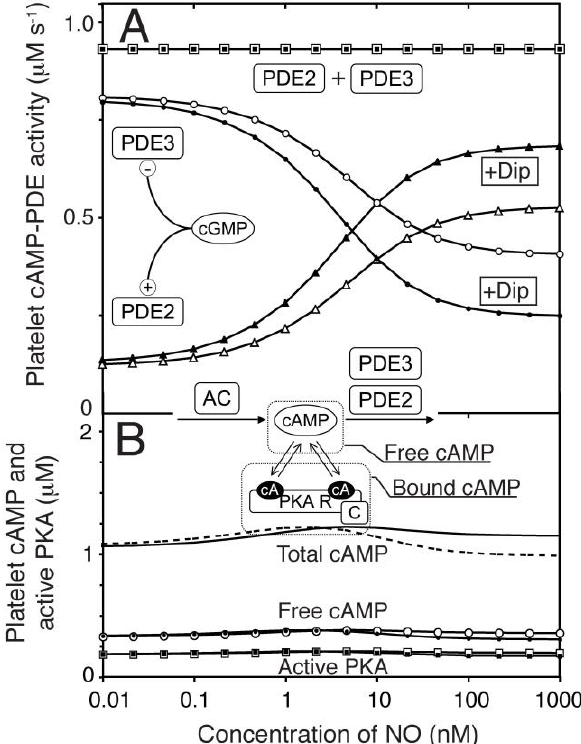
Figure 4. One compartment model of platelet NO/cGMP to cAMP/PKA signalling. We extended the model of the NO/cGMP signalling pathway to also include the relevant cAMP signalling components and adjusting the enzyme activities to reach experimentally observed cAMP levels at basal and NO stimulated conditions. ( A ) the predicted change in PDE2- ( ), PDE3- ( , ) and total cAMP-PDE- ( , ) activity was estimated in response to NO in absence (open) and presence (closed) of dipyridamole. In ( B ) we show the cAMP-response to NO for total cAMP (solid line without dipyridamole, dotted line with dip), free cAMP ( , ) and active PKA ( , ). Open and closed symbols denote absence or presence of dipyridamole (1.0 µM), respectively.